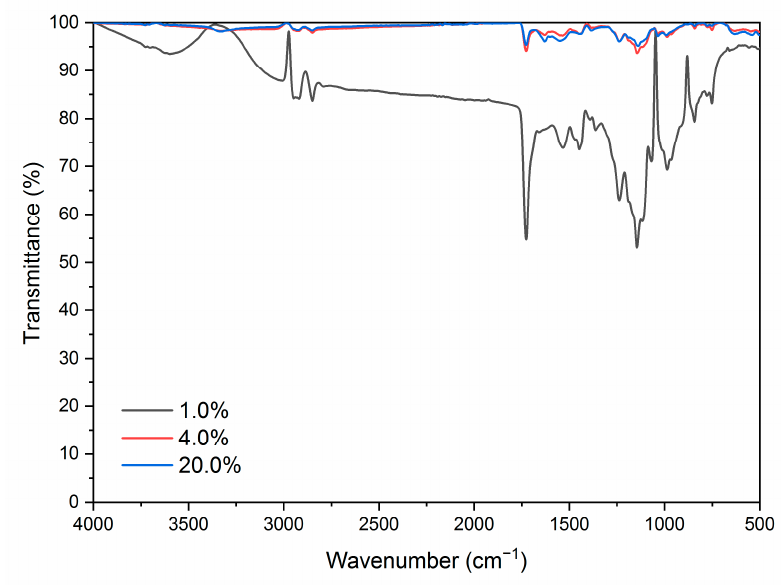
Figure 8. Infrared spectrum image of paint film with different contents of microcapsules (the ratio of core materials to shell material in mass of 0.65).